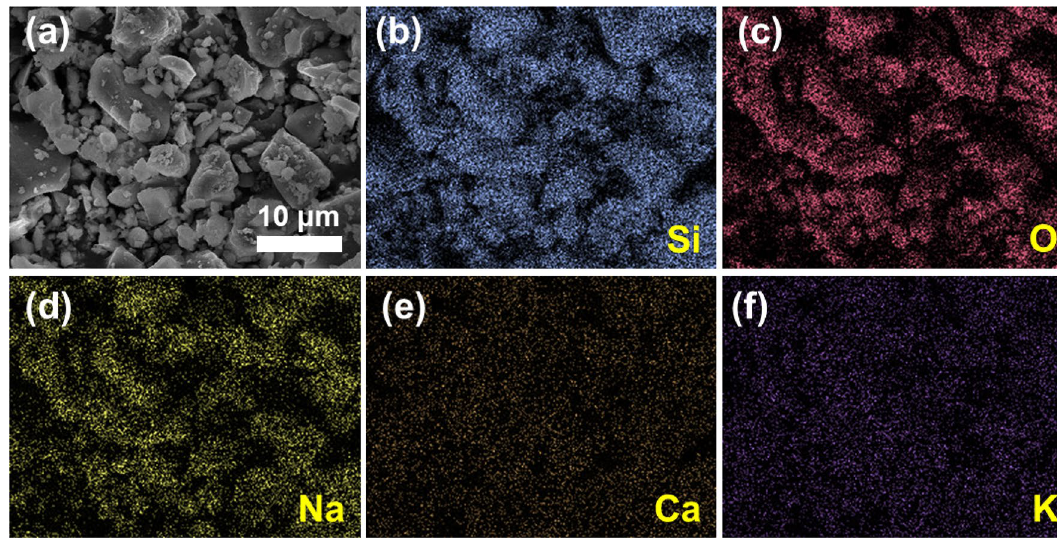
Figure 4. ( a ) SEM images of fabricated glass frit. ( b – f ) EDS mapping images.